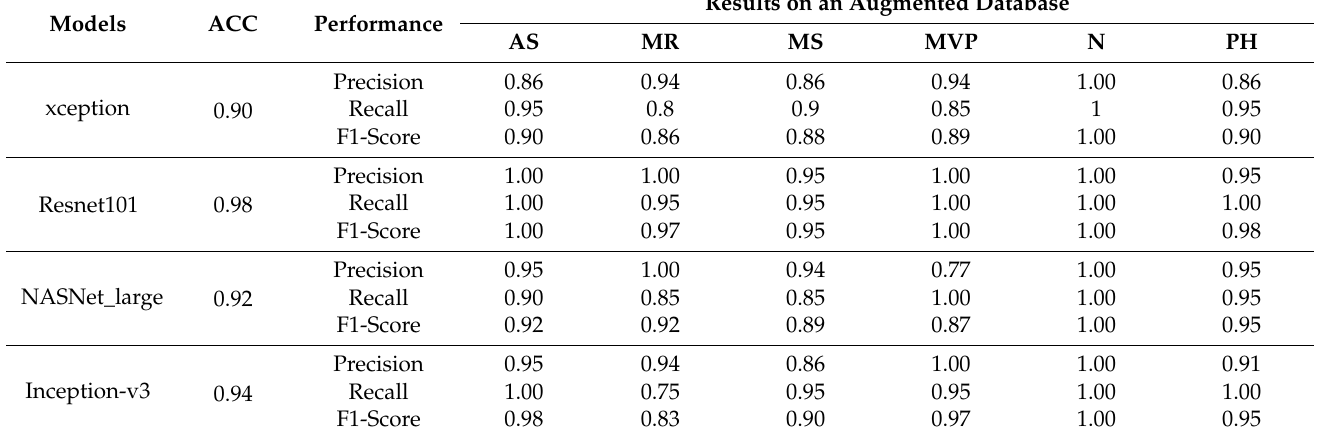
squeezenet. Table 7. Nine transfer learning models of classification performance based on augmented heart sound database.